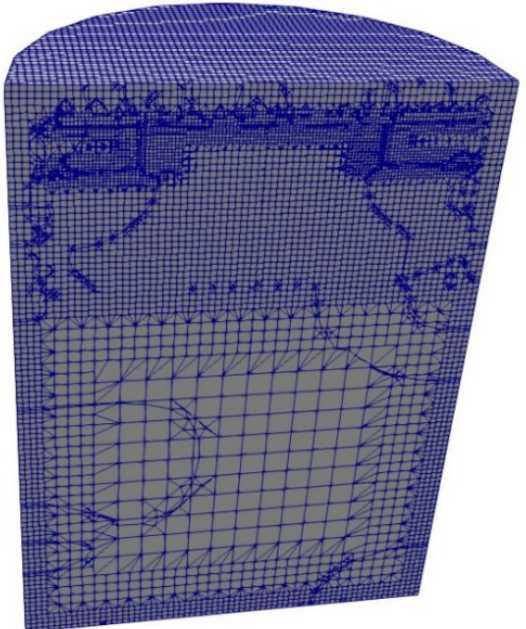
Figure 3. The computational domain and the mesh system.